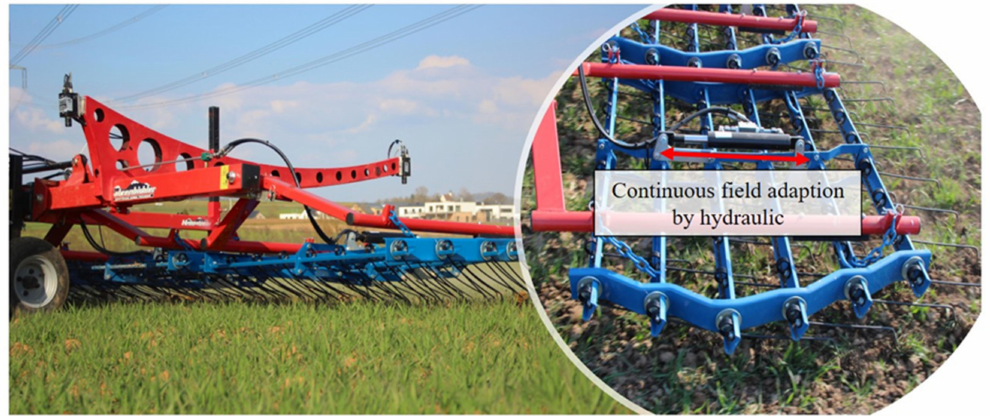
Figure 1. The sensor guided harrow in action, plus the hydraulic cylinder, which was used to adjust the tine angle to the actual field